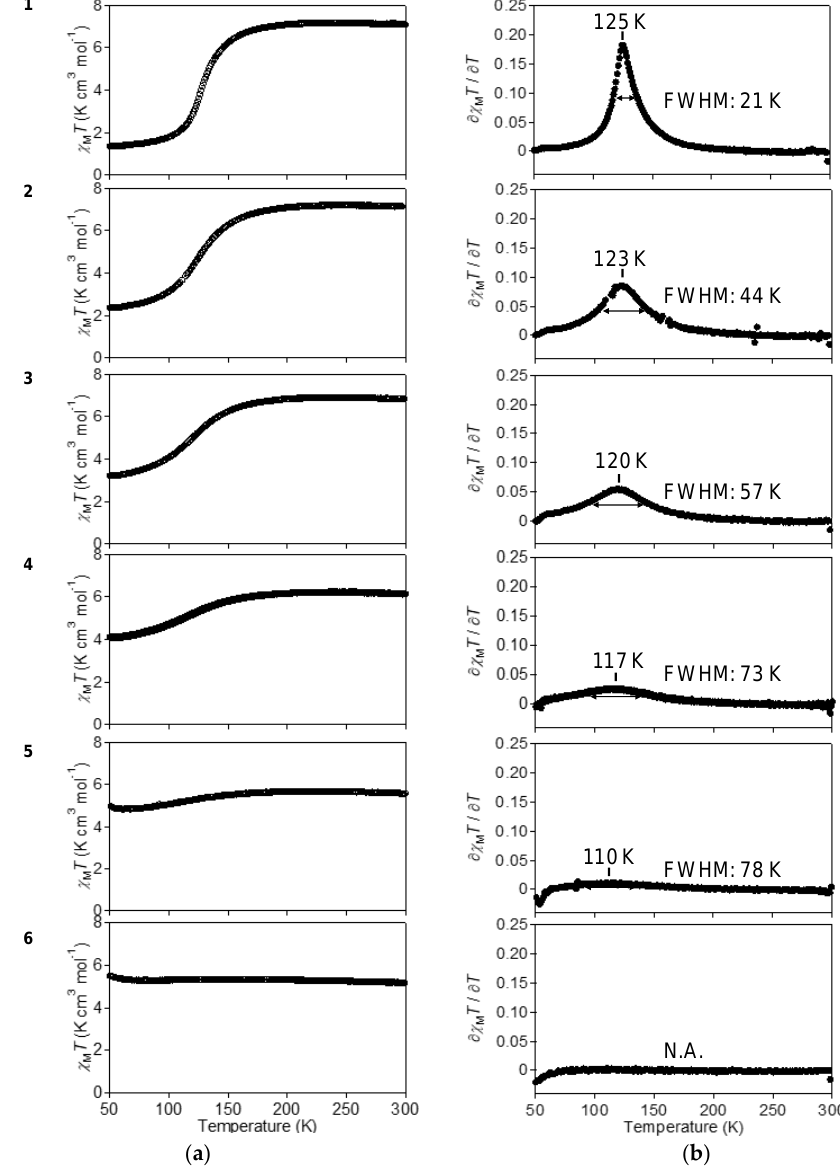
Figure 5. χ M T vs. T plots ( a ) and ∂( χ M T )/∂ T vs. T plots ( b ) of 1 – 6 .